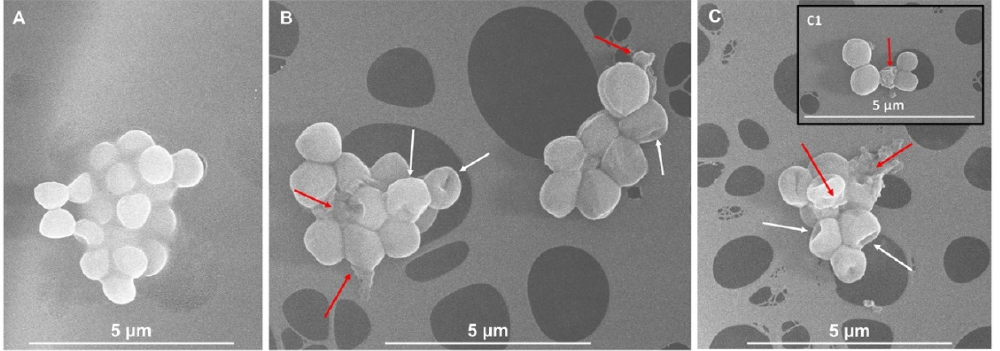
Figure 6. Scanning electron micrographs of unchallenged ( A ) or challenged S. aureus cells with lemon ( B ) and/or grapefruit ( C ) IntegroPectins. The inlet C1 shows a collapsed coccus cell. Nonorthodox cell morphologies are indicated by white arrows; cell death events are underlined by red arrows.